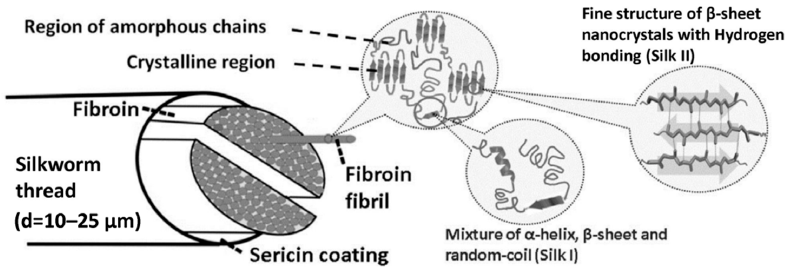
Figure 1. Schematic presentation of the silk fibroin (SF) structure; d represents the diameter of a single silkworm thread. Reproduced from [28].